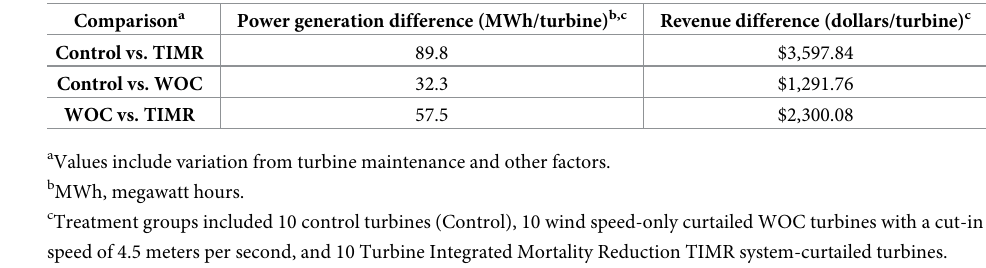
Table 5. Power loss based on differences in observed power production for 3 treatment groups at the Blue Sky Green Field Wind Energy Facility, Fond du Lac County, Wisconsin, July 15 − September 30,